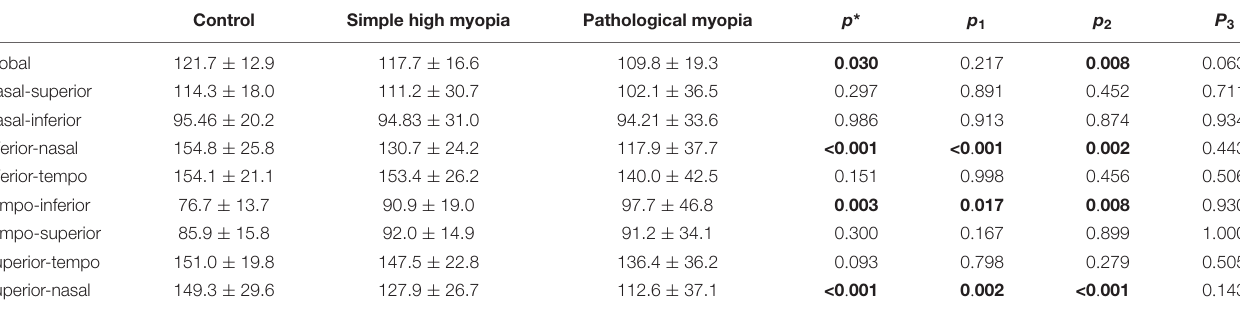
TABLE 3 | The peripapillary retinal nerve fiber layer (pRNFL) thickness ( µ m) among the control, simple high myopia, and pathological myopia. Control Simple high myopia Pathological myopia